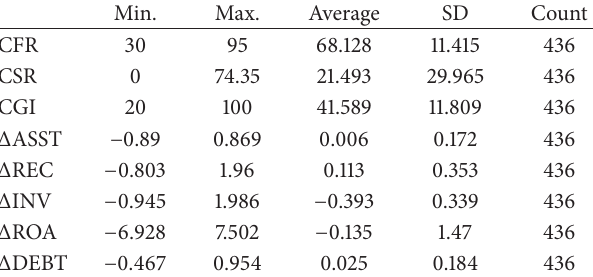
Table 5: Statistics of